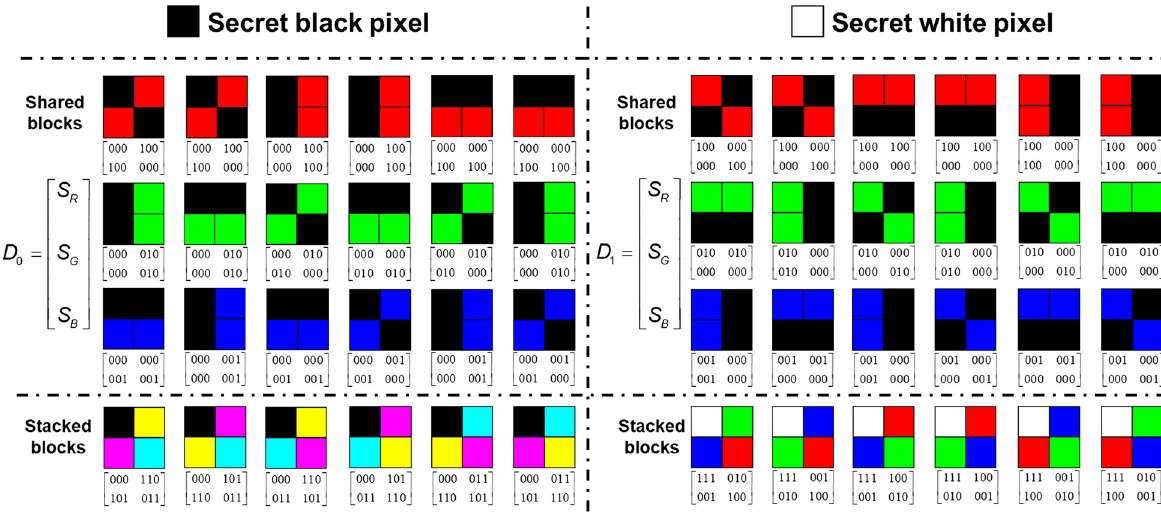
Figure 6: Graphical interpretation of six of 24 possible combinations of decoding